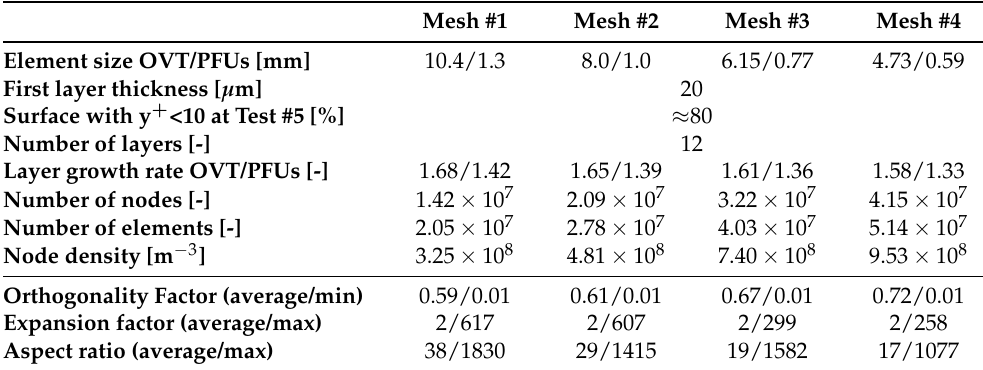
Table 5. Adopted mesh parameters and quality metrics.